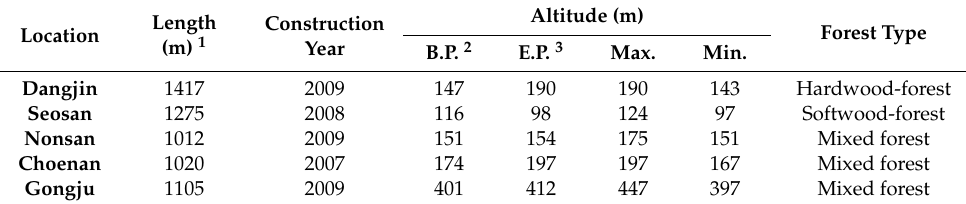
Figure 1. Study site locations. Table 1. Information on study forest road routes.